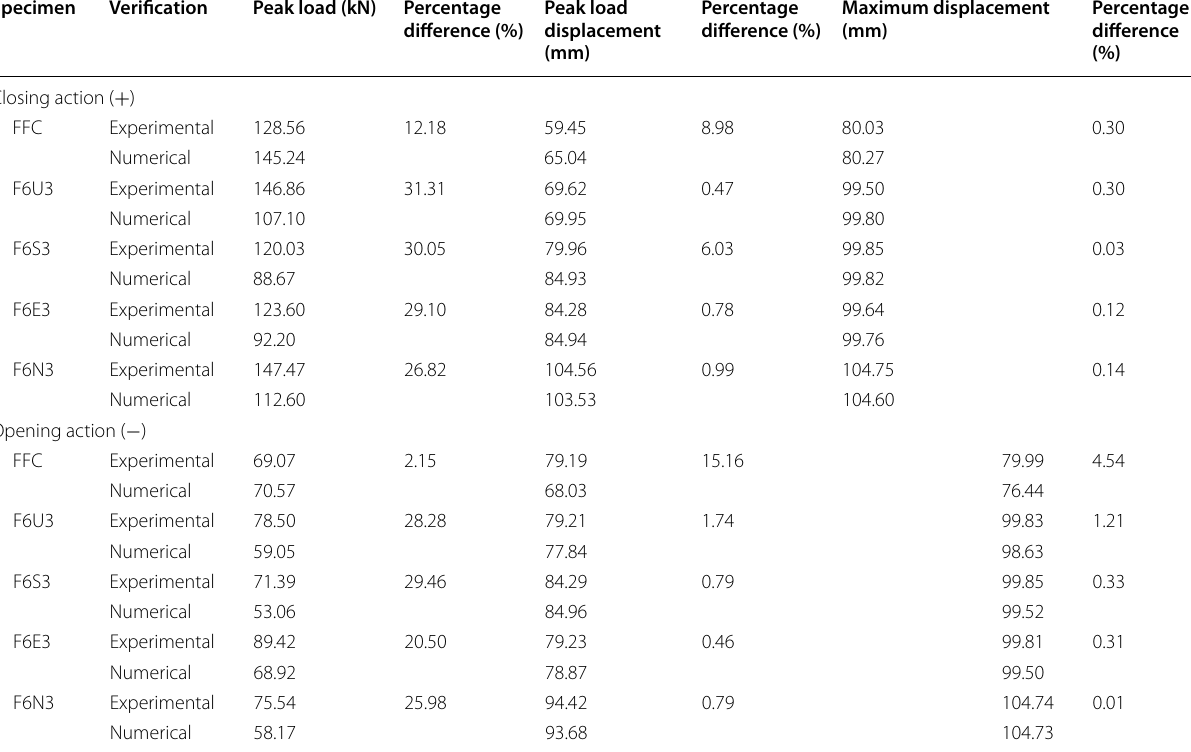
Table 9 Knee joint experimental and numerical comparison in closing and opening actions